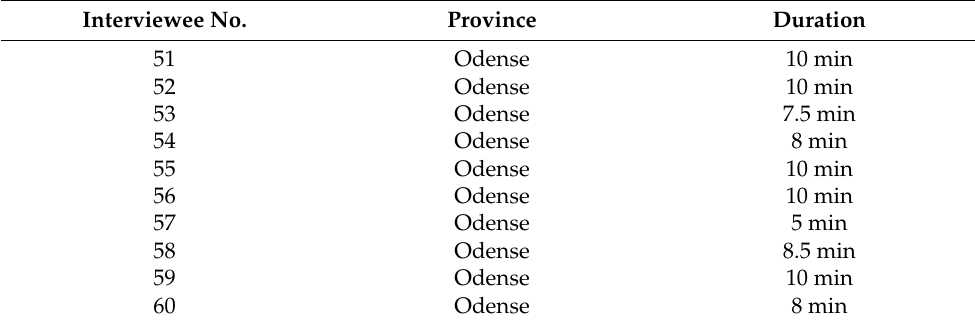
Table A6. Interviews and Interviewees of Danish Participants: Segment 3. Interviewee